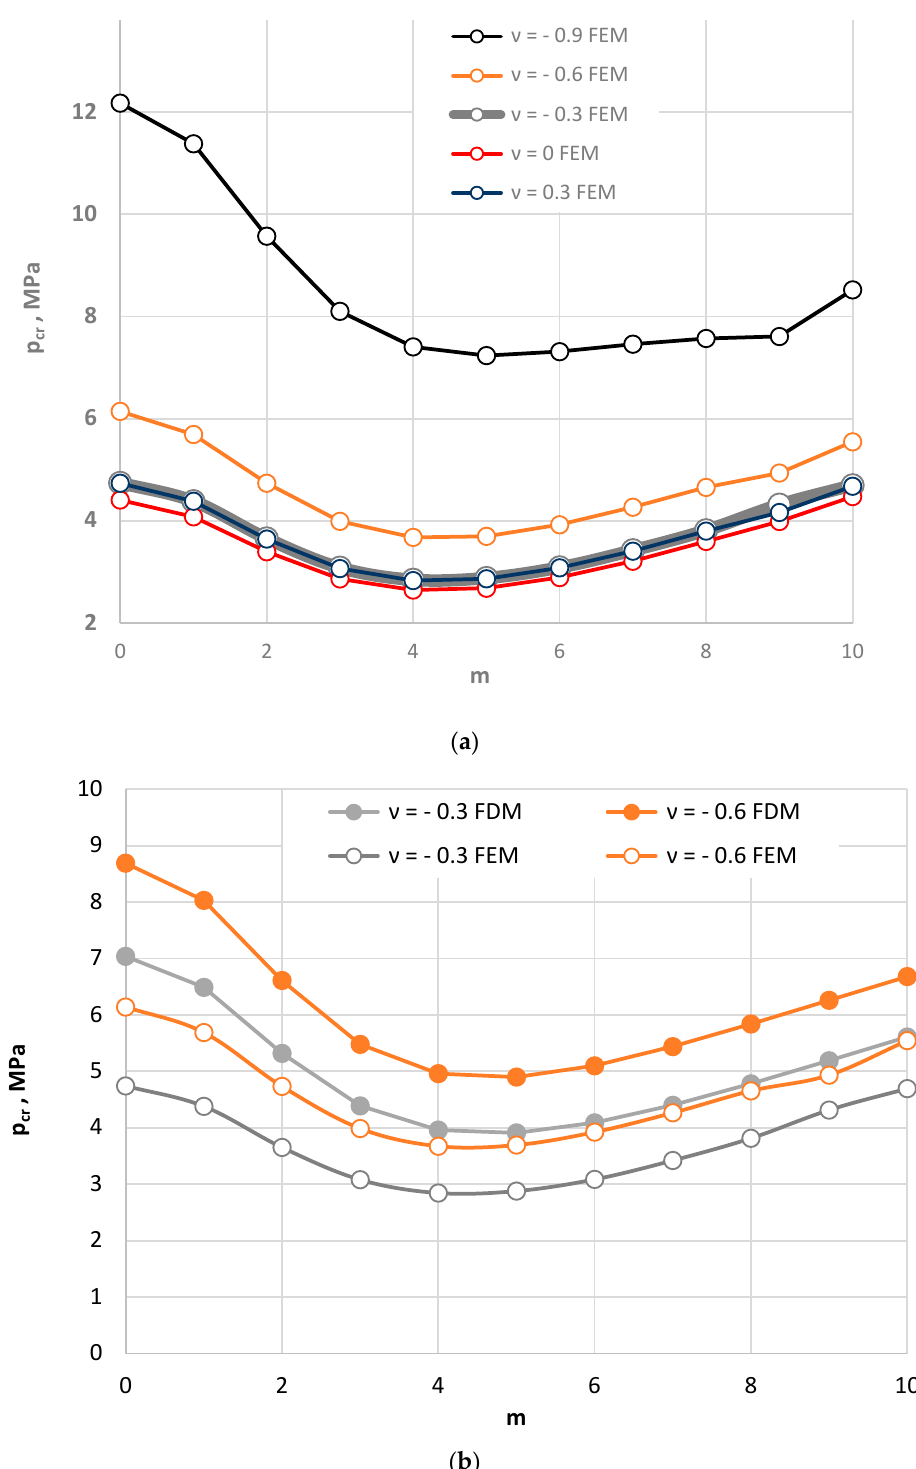
Figure 9. Critical static load p cr distribution versus mode m for three-layered plates radially com- pressed on the outer edge: FEM plate model ( a ), FDM and FEM plate model ( b ). Figure 9a shows the results obtained using the finite element method for plates with auxetic properties. The distribution of values of the critical load p cr as a function of the mode m confirms the calculations performed for plates with traditional facings. A signif- icant increase in the value of p cr can be observed for plates with auxetic facings with a high